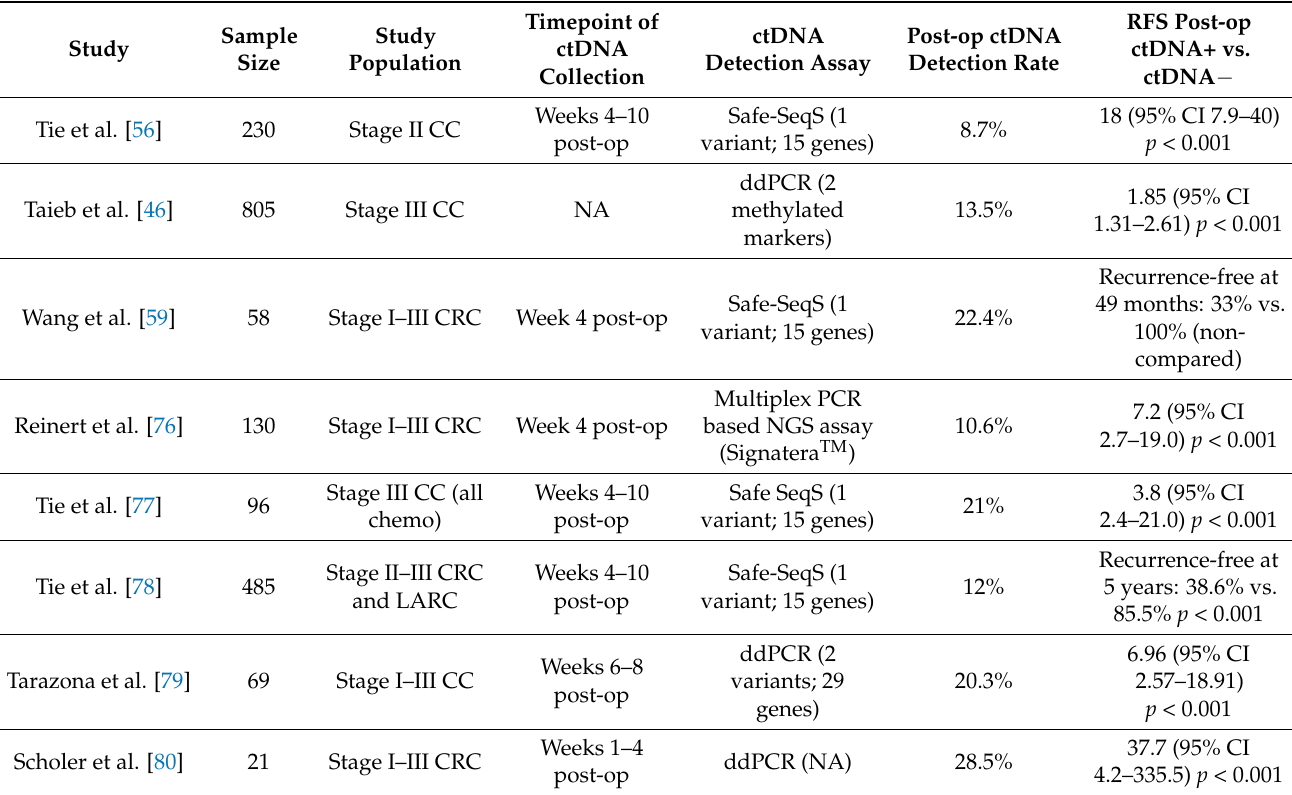
Table 1. ctDNA as prognostic marker in early-stage colorectal